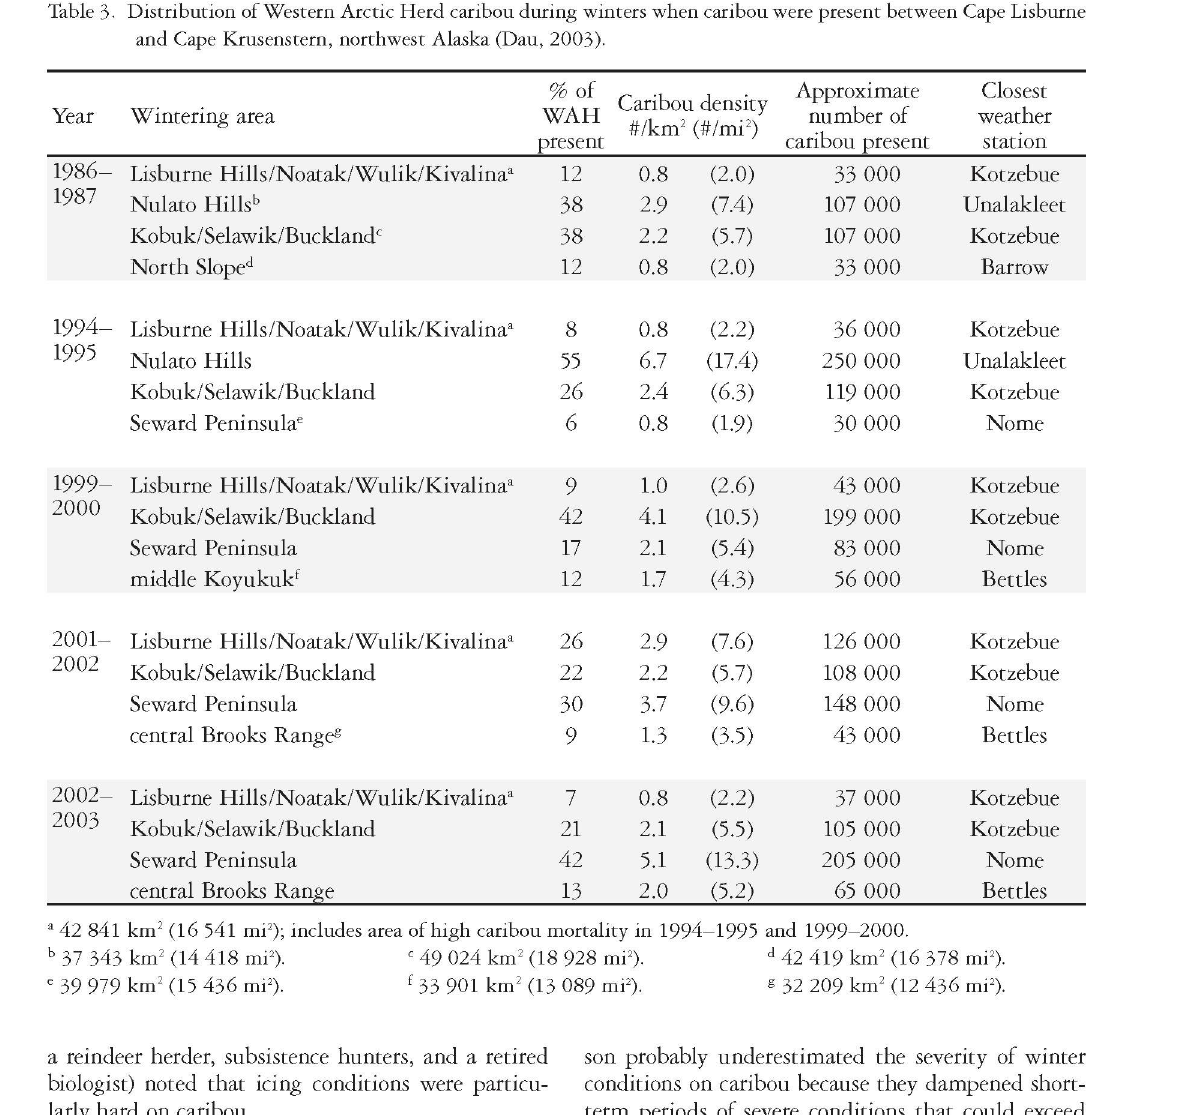
Table 3. Distribution of Western Arctic Herd caribou during winters when caribou were present between Cape Lisburne and Cape Krusenstern, northwest Alaska (Dau,